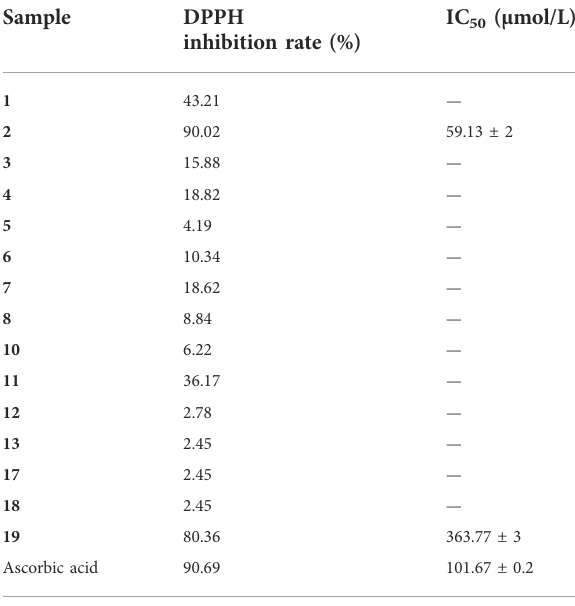
TABLE 4 Inhibition of NO production with IC 50 values of compounds 17 and 19 a .